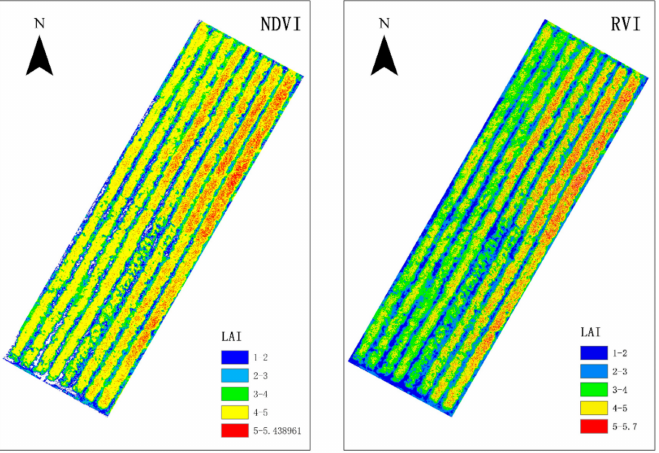
Figure 7. Prediction map of the RVI and NDVI vegetation indices for